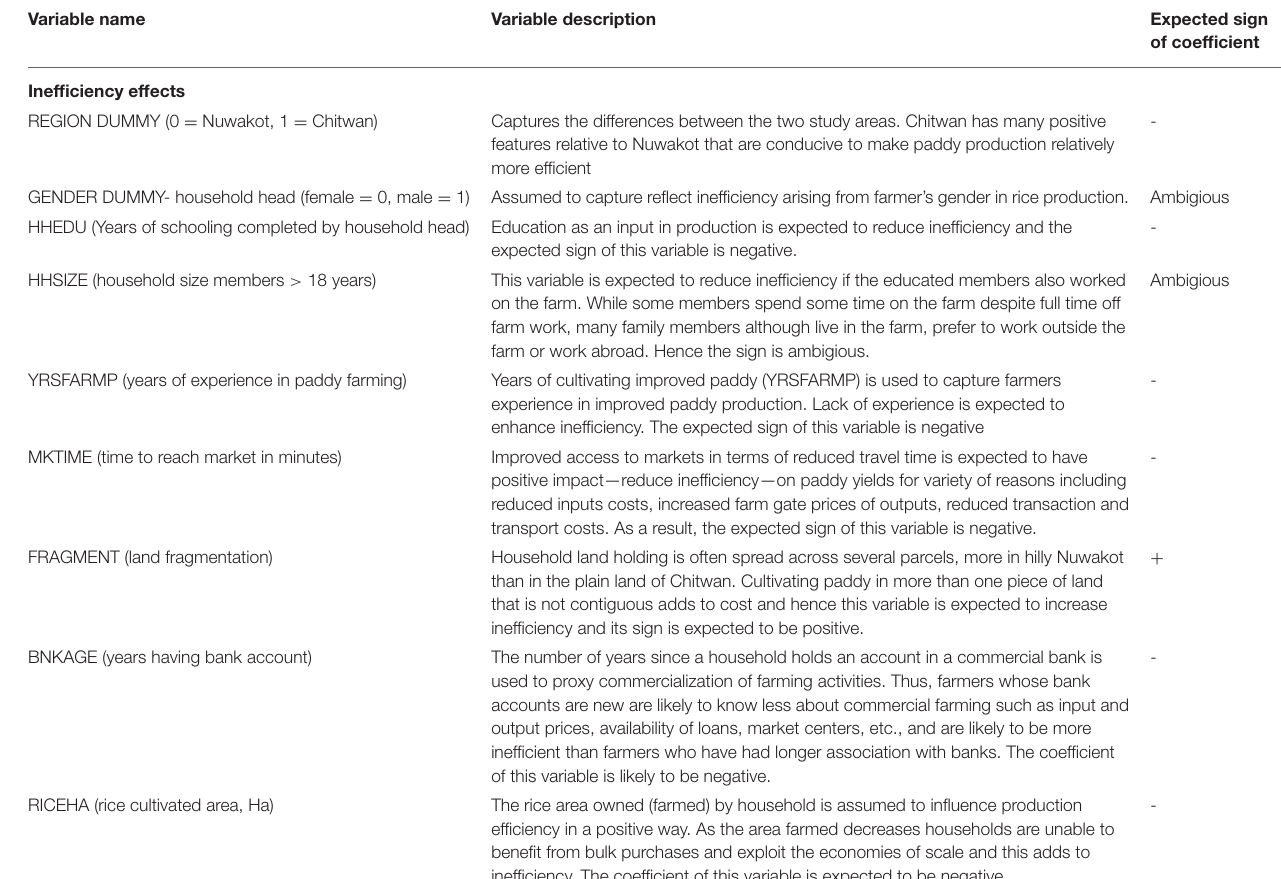
TABLE 1 | Variables used in the study.